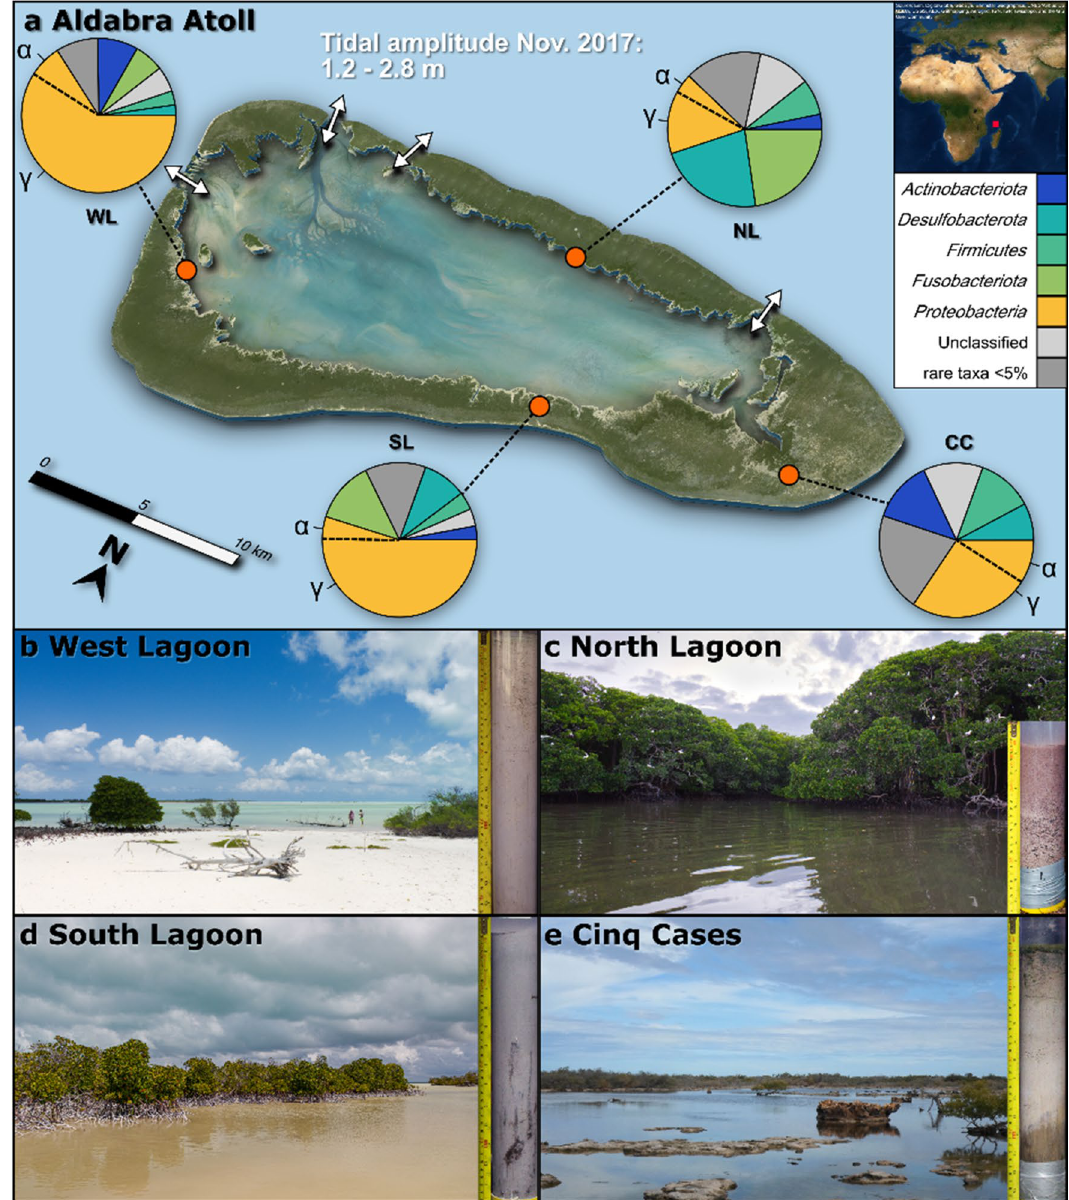
Figure 1. Aldabra Atoll, sampling sites and most abundant bacterial phyla (> 5%) at each site. ( a ) Map of the Aldabra Atoll showing the main tidal channels (white arrows), tidal amplitude and four sampling sites. The global location is indicated in the top right corner, on a map generated using ArcGIS Desktop and Esri World Imagery (July 17, 2020). Most abundant bacterial phyla across all samples are shown in pie charts by sampling site: All taxa below 5% relative abundance were summarized as rare taxa. ( b – e ) Sampling sites and a representative core for each location. ( b ) The sediment cores were sampled near the bottom left corner of the image when sands were completely exposed. ( c ) Cores were taken towards the left of the image in karst holes, the site was submerged at all times. ( d ) Cores were taken towards the bottom of the image while the area was completely exposed at low tide. ( e ) cores were taken towards the middle of the image, submerged in shallow